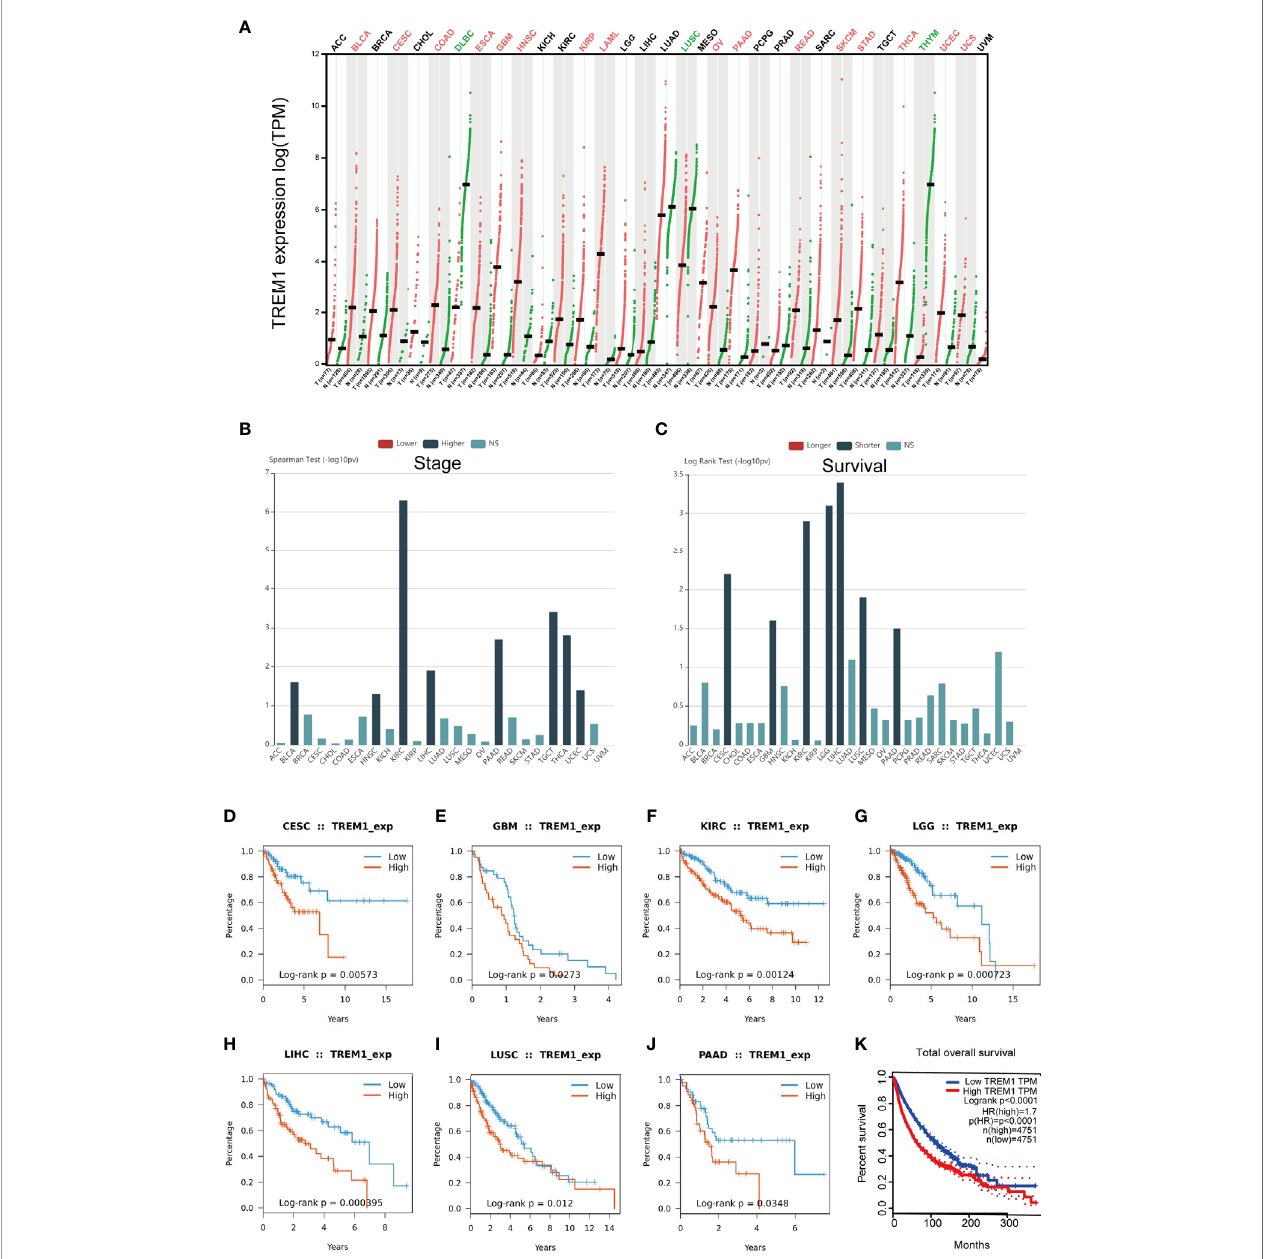
FIGURE 6 | Generalization value of TREM-1 across cancers. (A) Comparison of TREM-1 mRNA expression between cancer and paracancerous tissues across cancers. (B) Associations between TREM-1 expression and stage across human cancers. (C) Associations between TREM-1 expression and OS across human cancers. K-M survival analysis between the L-TREM-1 and H-TREM-1 groups in the (D) CESC, (E) GBM, (F) KIRC, (G) LGG, (H) LIHC, (I) LUSC, (J) PAAD and (K) pan-cancer